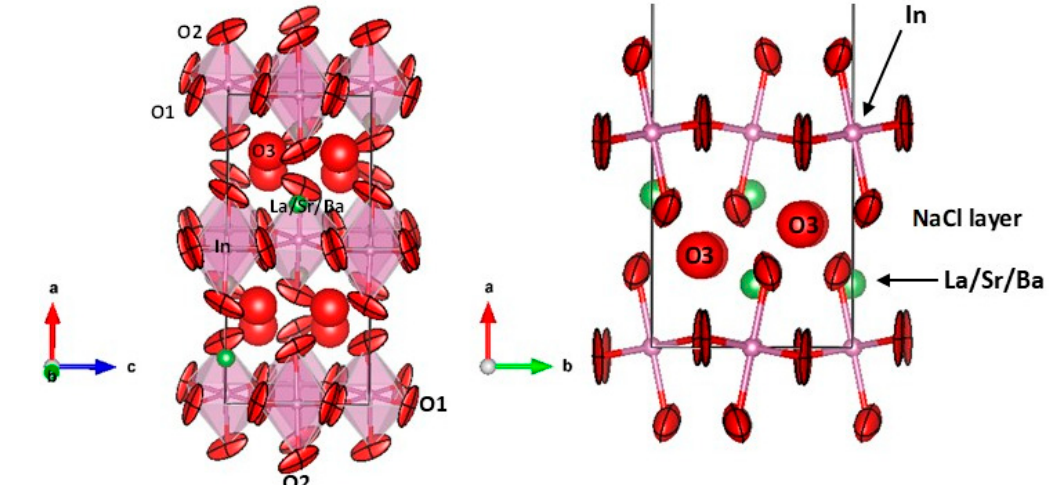
Figure 4. Crystal structure views of La 1.2 Sr 0.5 Ba 0.3 InO 4+ δ , showing sheets of tilted InO 6 octahedra alternating with (La/Sr/Ba)–O layers, where interstitial O3 oxygen atoms are located, highlighting the anisotropic displacement parameters, of oblate type for equatorial O1 and prolate type for axial O2 oxygen atoms. The ellipsoids are represented with 95% of probability. The right panel highlights the NaCl layer where O3 interstitials are accommodated taking advantage of the space left by the octahedral tilting. Figures were made using the VESTA program.